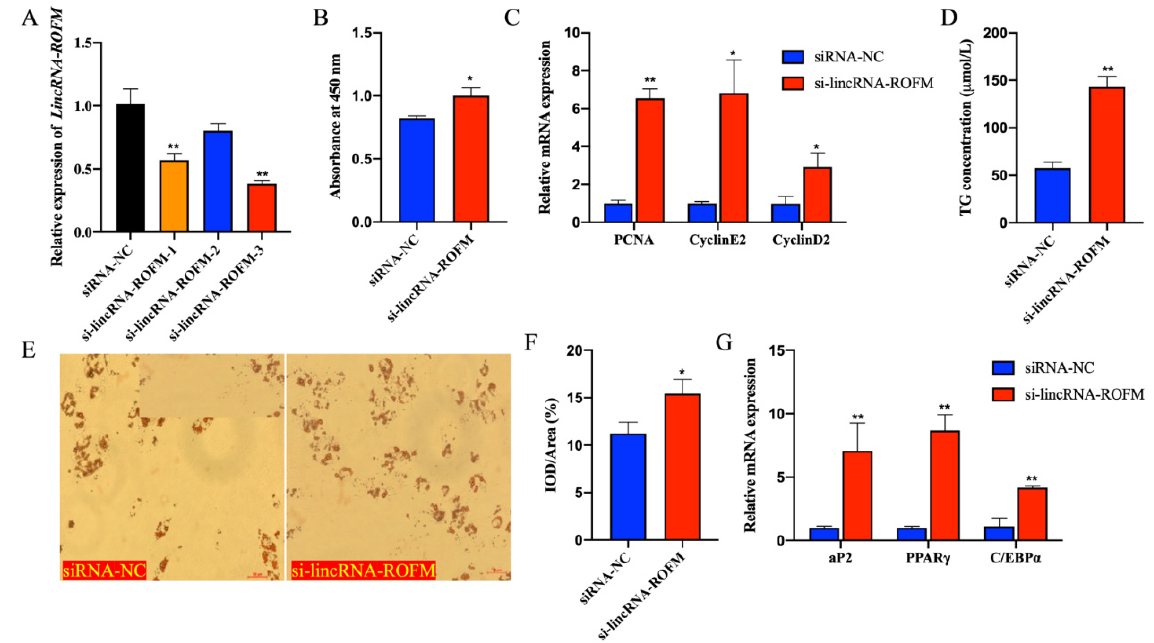
Figure 5. LincRNA-ROFM knockdown promoted the proliferation and differentiation of porcine preadipocytes. ( A ) The relative expression levels of LincRNA-ROFM in porcine preadipocytes trans- fecting with siRNA 1, 2, and 3. ( B ) Proliferation of porcine preadipocytes following transfection with LincRNA-ROFM siRNA after 48 h detected by CCK8 assay. ( C ) mRNA expression levels of PCNA , cyclinE2, and cyclinD2 in porcine preadipocytes transfected with LincRNA-ROFM siRNA after 48 h detected by RT-qPCR assay. ( D ) After extracting Oil Red O with isopropanol, the OD value (510 nm) was detected following transfection with LincRNA-ROFM siRNA after 6 days. ( E , F ) Photomicro- graphs and quantitative of Oil Red O showed transfection with LincRNA-ROFM siRNA increased the lipid accumulation after 6 days. Scale bar, 50 mm. ( G ) mRNA expression levels of PPAR γ , aP2, and C/EBP α in porcine preadipocytes transfected with LincRNA-ROFM siRNA after 6 days as de- tected by RT-qPCR assay. Data are presented as the mean ± SEM (n = 3) vs. siRNA-NC, * p < 0.05 , ** p < 0.01.